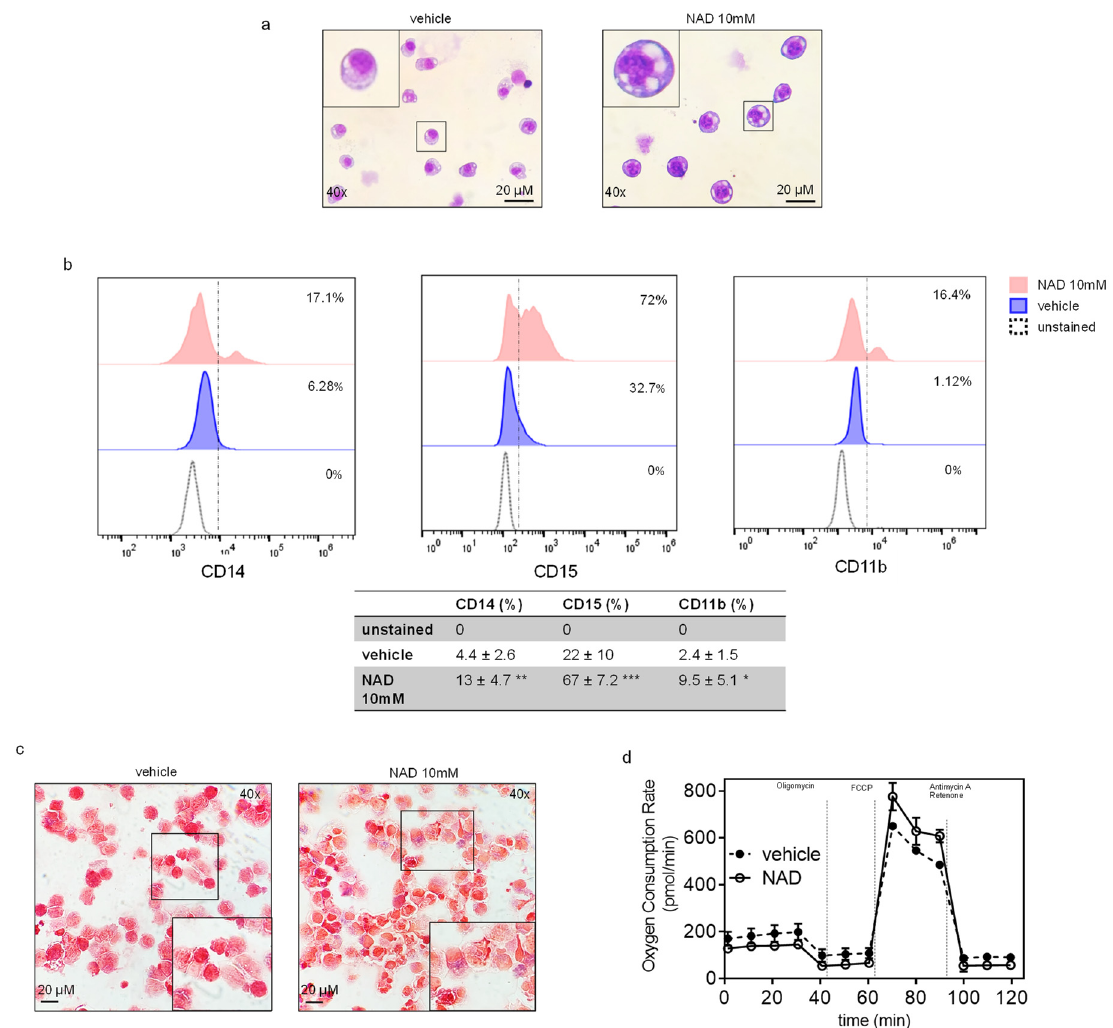
Figure 5. NAD induces myeloid differentiation in K562. ( a ) Wright Giemsa staining showing morphological changes between NAD-treated and control cells after four days. The figure is representative of five independent experiments ( b ) Representative image showing the increase in the surface markers CD15, CD14 and CD11b upon NAD treatment by flow cytometry. The table reports the mean % ±SD of CD14 + , CD15 + , CD11b + cells of five independent experiments. *: p < 0.05; **: p < 0.01; ***: p < 0.001 vs. vehicle ( n = 5) ( c ) NBT positive staining detected by small blue dots after counterstaining the cells with safranin. A magnification is shown in the rectangle. The pictures are representative of five independent experiments ( d ) Seahorse XF analysis of K562 mitochondrial stress response in cells treated with NAD or vehicle. The figure represents the mean of three biological replicates ( n = 3). Error bars indicate ± s.d.